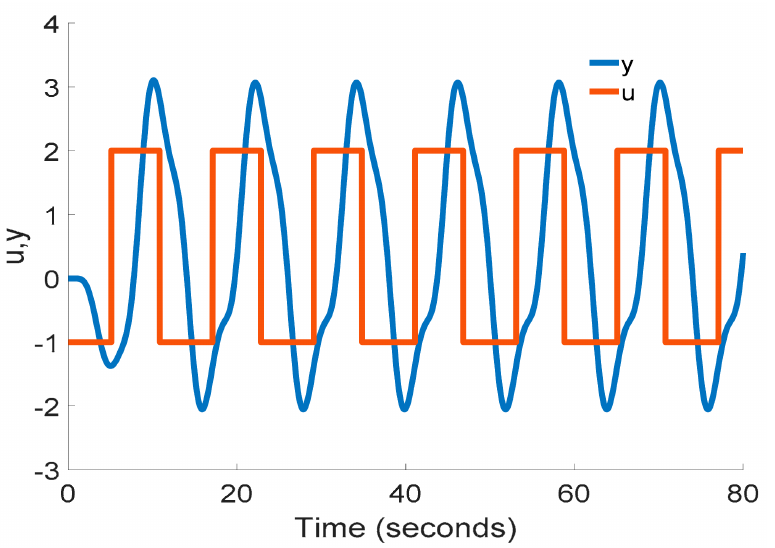
Figure 11. The relay output u and the observed output y of the process P2(s) controlled by the relay with the additional delay D = 3